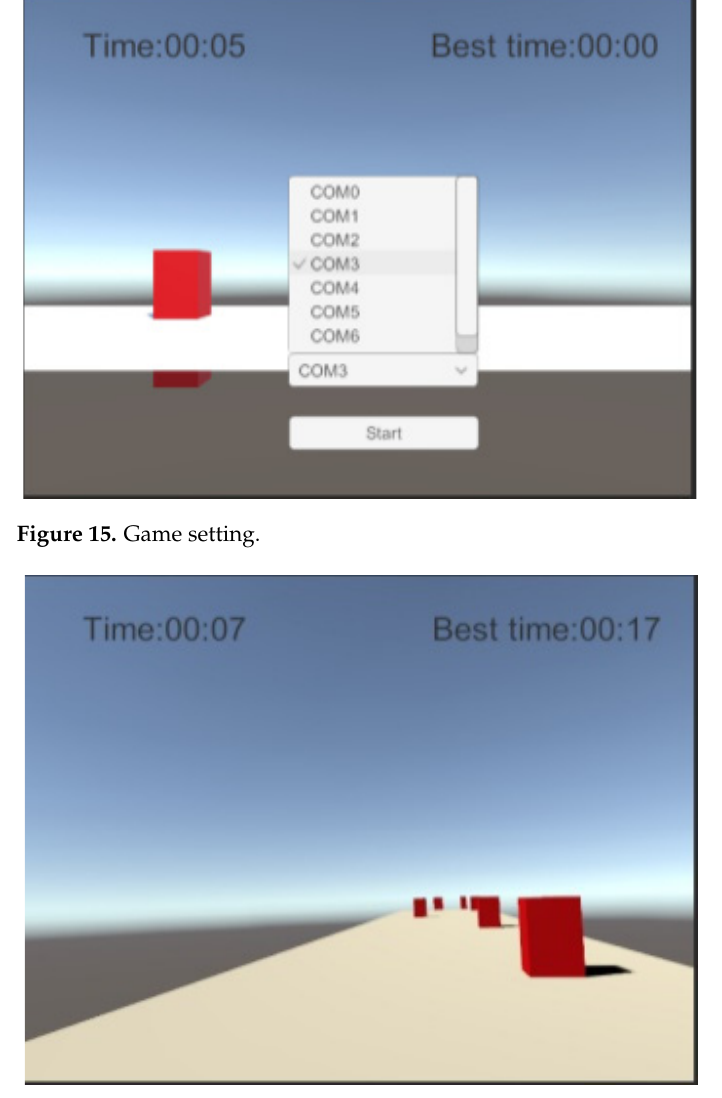
Figure 16. Game picture. Figure 17 is the VR system flowchart. The Bluetooth COM port needs to be connected